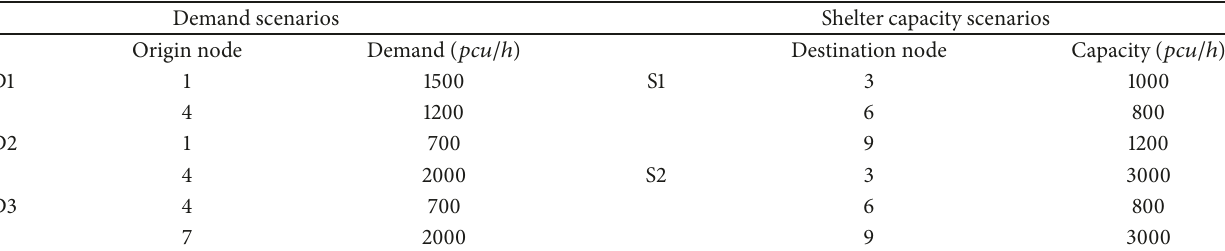
Table 8: Information of different demand and shelter capacity scenarios.